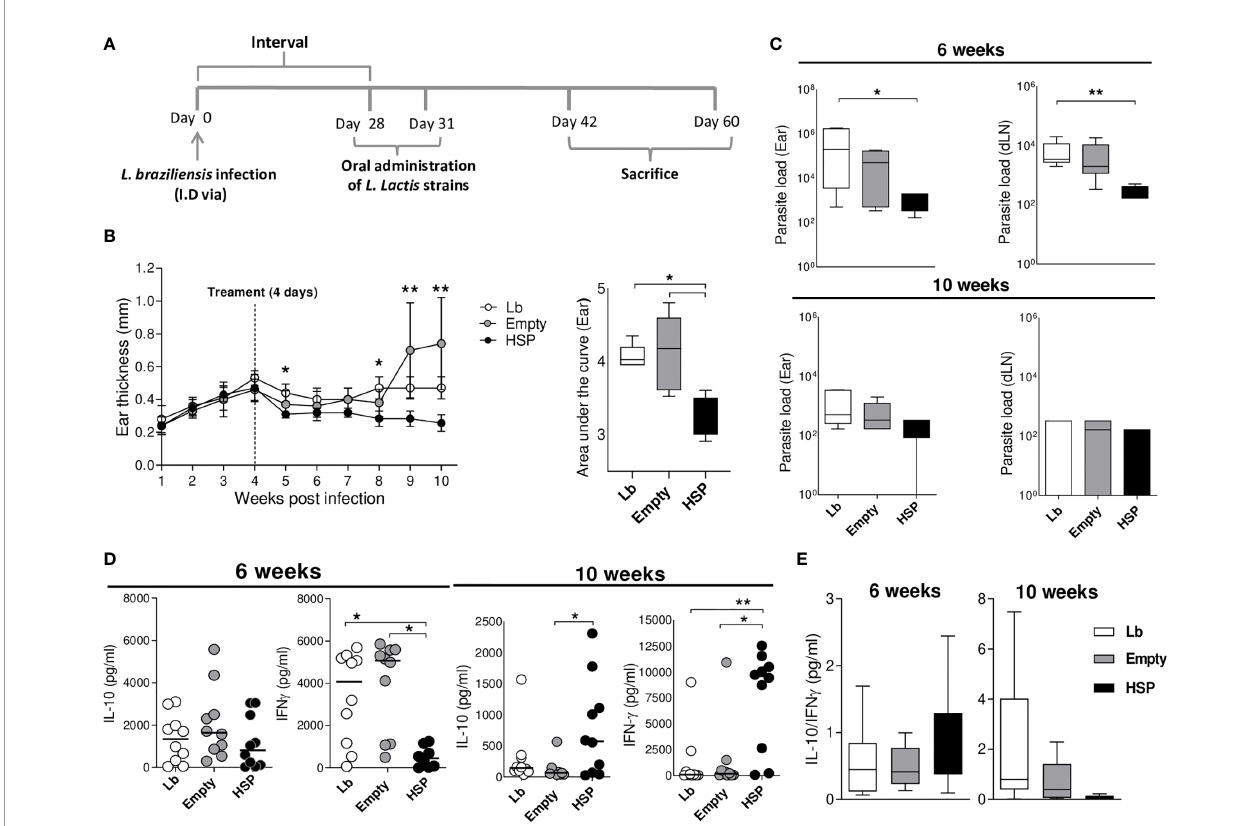
FIGURE 7 | Oral treatment with L. lactis -Hsp65 post-infection. Mice were infected with Leishmania braziliensis metacyclic promastigotes in the ear, and four weeks after infection received oral treatment consisting of water (Lb), GM17 medium with empty-vector-bearing L. lactis (Empty) or XM17 medium containing Hsp65 - producing L. lactis (Lb and HSP) for 4 consecutive days. (A) Experimental design of the post-infection treatment protocol in BALB/c mice. (B) Ear thickness was measured weekly. The area under the curve (right panel) was constructed using measurement data from each group. Data are representative of three independent experiments involving 10 animals per group. (C) Parasite load in the ear and draining lymph node lesions was determined by limiting dilution at 6 and 10 weeks post- infection. (D) Mice were euthanized at 6 and 10 weeks post-infection; draining lymph node cells were cultured and restimulated in vitro with live metacyclic promastigotes of L. braziliensis for 72 hrs. Cell culture supernatants were then collected for cytokine quanti fi cation by ELISA. (E) Ratio of IL-10/IFN- g production. Data are representative of medians and interquartile range from each group. For nonparametric data, Krukal-Wallis with Dunns post-test was used. (*) P < 0.05 [between Lb and HSP groups at 5 and 8 weeks, (B) ]; (**) P < 0.001 [between Empty and HSP groups at 9 and 10 weeks, (B)